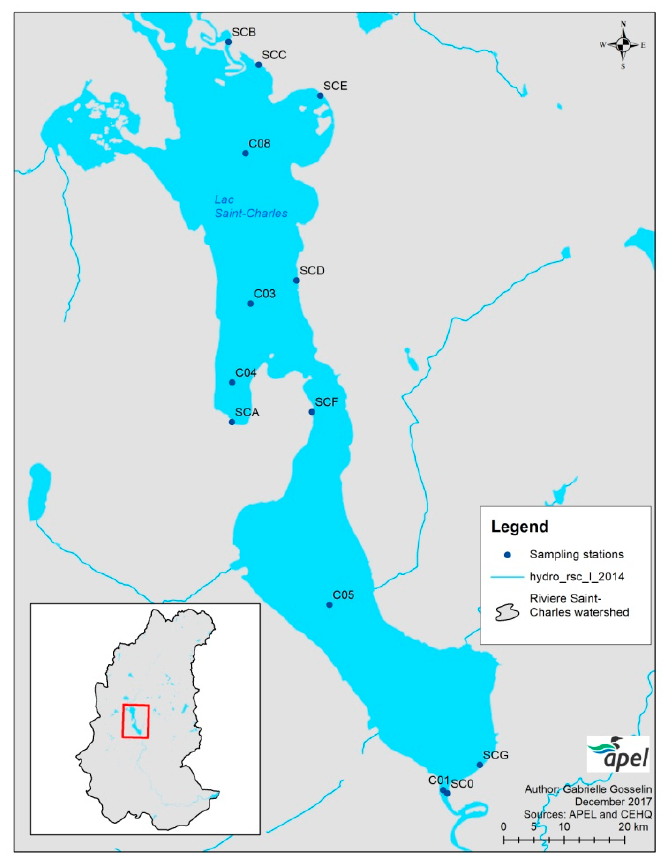
Figure 9. Distribution of sampling stations on Lac Saint-Charles (lake). Maximum depth at each station: C03: 17 m, C08: 13 m, C04: 7.5 m, C05: 5 m, and C01: 2 m). Reproduced with permission from [21], APEL, 2019.